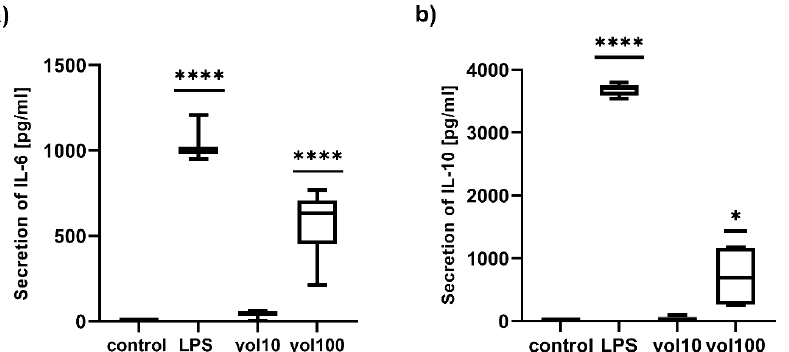
Figure 6. The impact of yolkin on IL-6 ( a ) and IL-10 ( b ) production by BMDM cells. BMDM cells (1 × 10 6 /mL) were stimulated with yolkin (10 and 100 ug/mL) or LPS (1 µ g/mL). After 24 h of stimulation, supernatants were collected, and the level of cytokines was determined using ELISA. Results are presented as mean with min–max ( n = 3–4). A Kruskal–Wallis test was used to examine the mean differences between samples and control * p ≤ 0 .05; **** p ≤ 0 .00001; ns (not significant) vs. control.